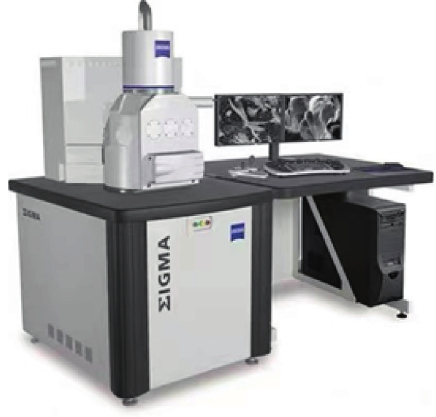
Figure 11: Field emission scanning electron